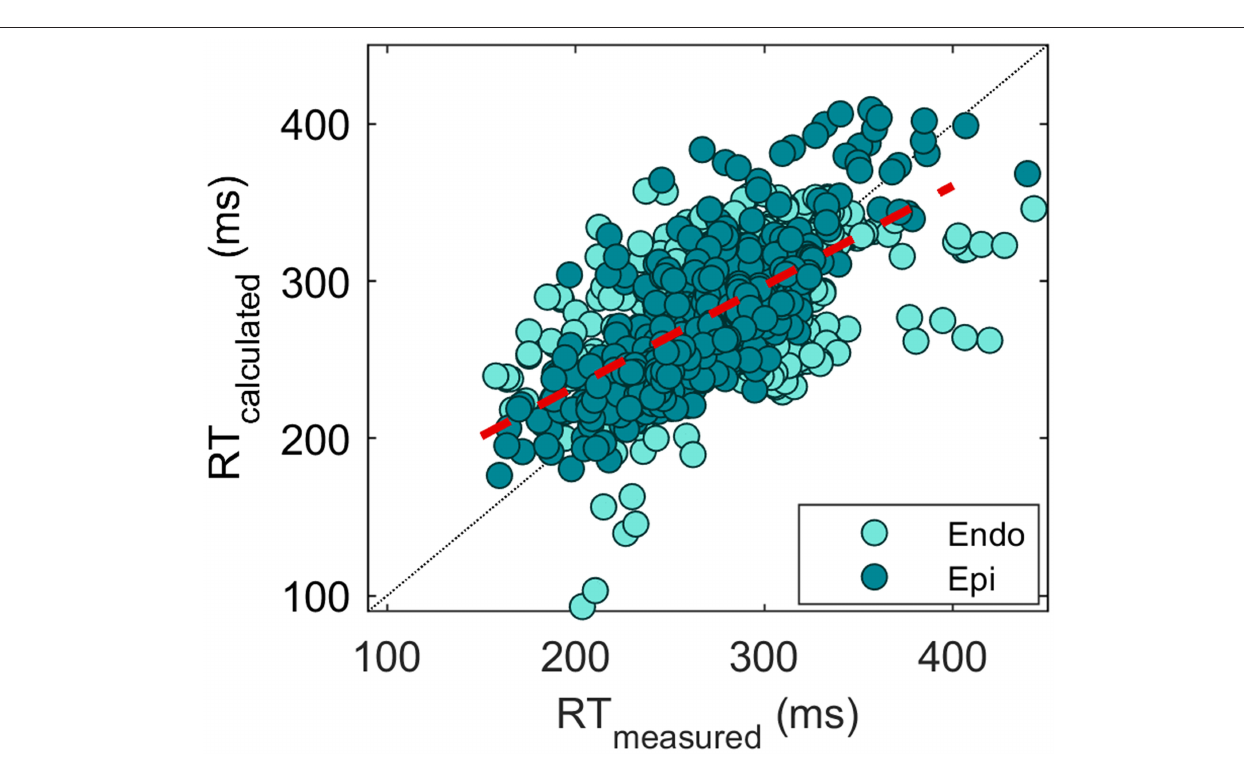
FIGURE 6 | Scatterplot of measured vs. reconstructed RTs ( n = 1,643). Each point indicates an electrode location in the heart. A distinction between the endocardial (turquoise) and epicardial (green) measurement sites is made. The overall correlation of 0.63 is depicted by the red dashed